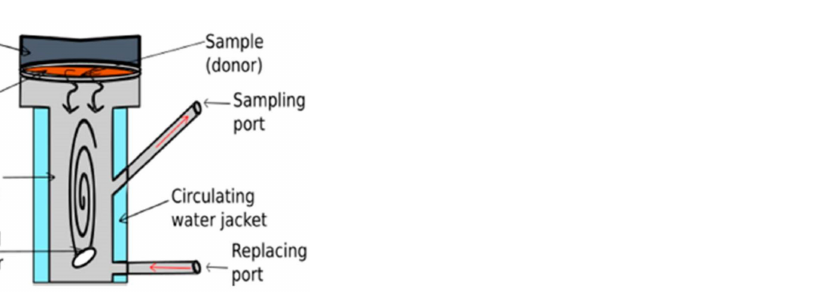
Figure 5. Franz-diffusion cell schematics (adapted with permission from Scientia Pharmaceutica, a MDPI Opena Access Journal